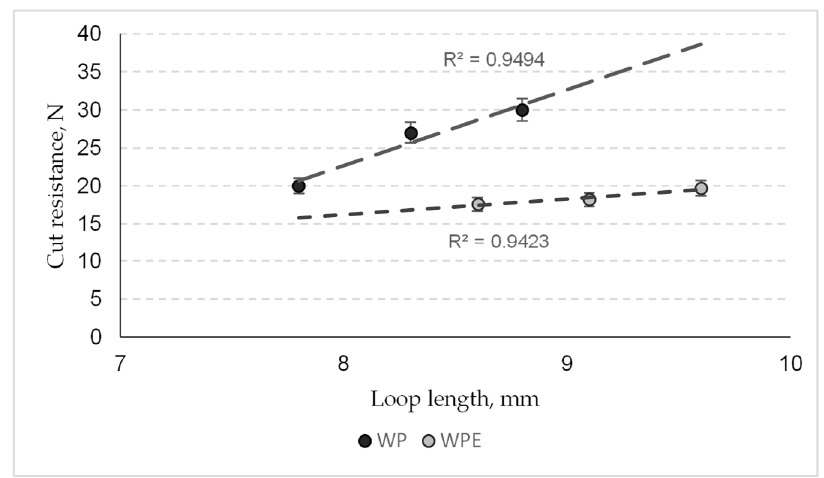
Figure 3. Cut Figure 3. Cut resistance.